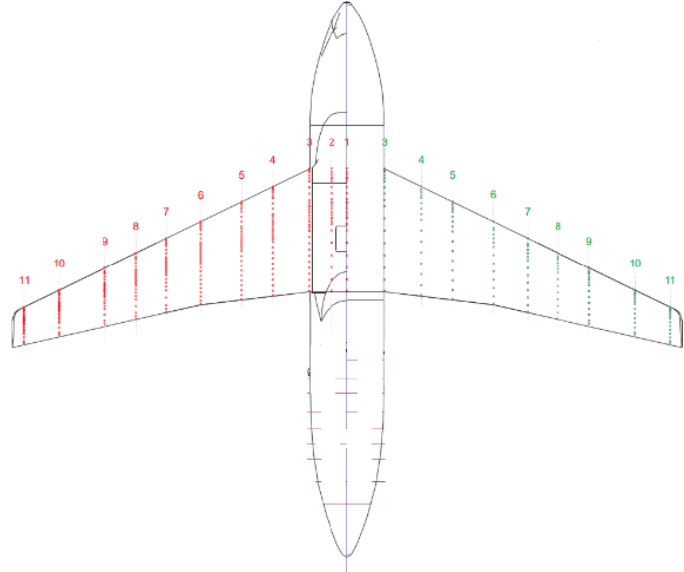
Figure 2. Model configuration and distribution of orifice taps.